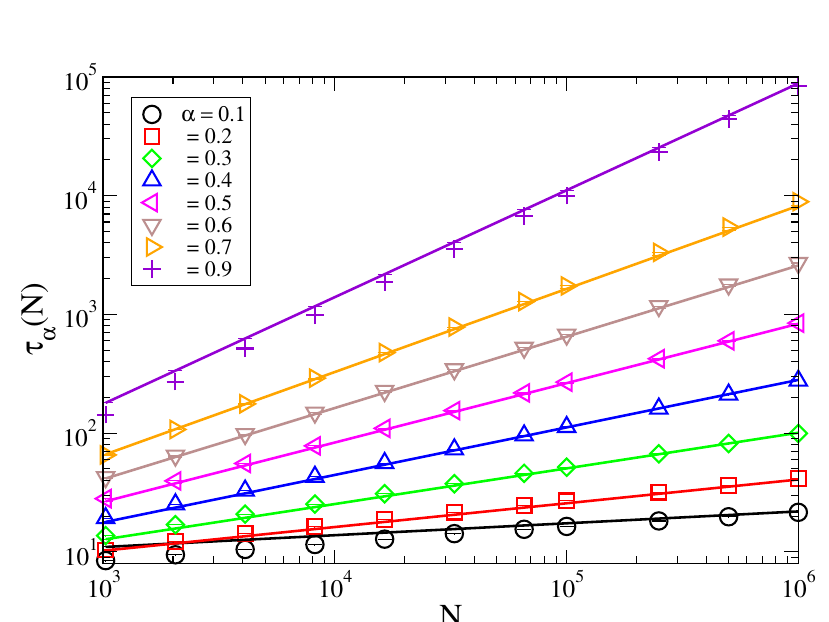
Figure 1: The time τ α ( N ) taken by a system initially made by two domains of size N / 2 to reach a fully ordered state is plotted against N , on a double logarithmic scale. Symbols are outcomes of numerical simulations for various α (see caption). Each curve is averaged over 10 5 Monte Carlo samples. Continuous lines are the algebraic behavior τ α ( N ) = k ( 1 /α )( N / 2 ) a , with k =